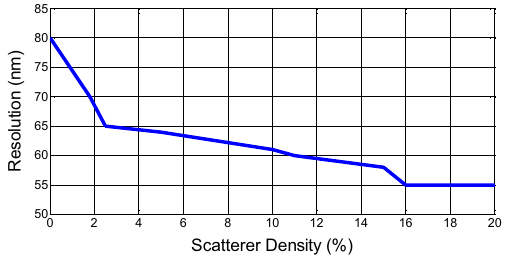
Figure 4. Focusing resolution versus scatterer density inside the tissue